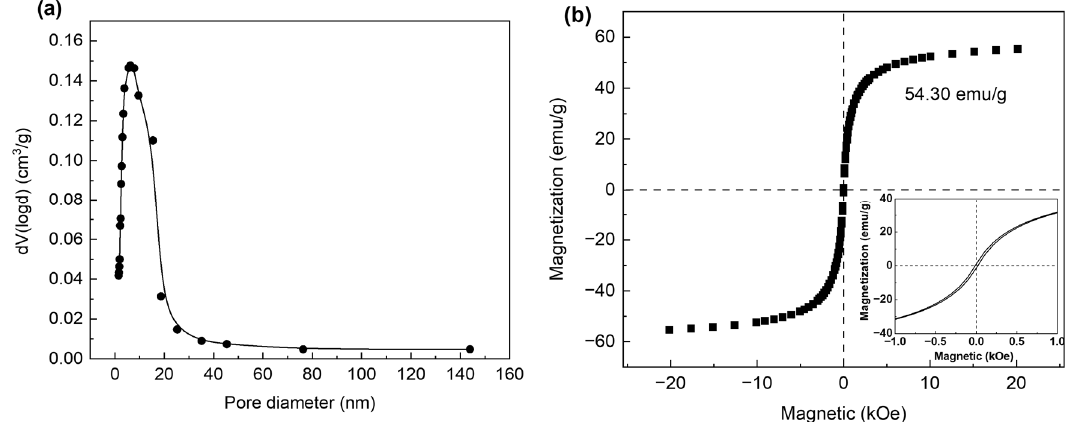
Figure 3. Pore-size distributions ( a ) and magnetization curves ( b ) of IONPs@MAH- β -CD.